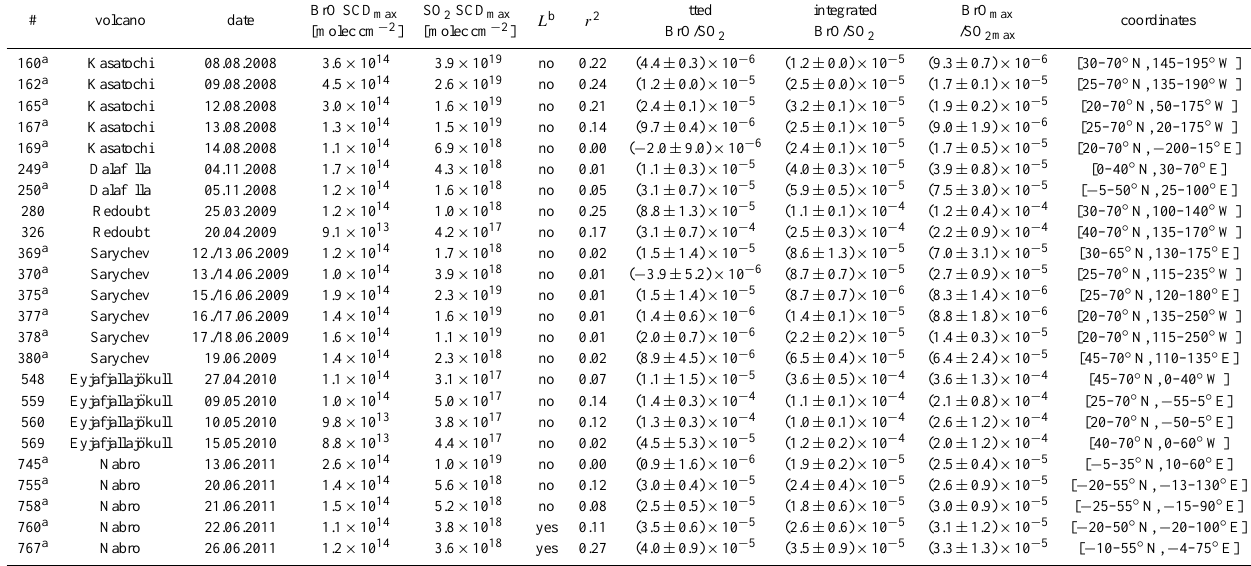
Table 6. Category III ( eruptions with enhanced BrO cluster, but no linear correlation ) BrO/SO 2 -analysis of all detected volcanic plumes of Category III. Columns contain: event number, volcano, measurement date, max. BrO SCD, max. SO 2 SCD, coincidence of max. SO 2 and BrO SCD, r 2 , BrO/SO 2 slope, ratio of integrated BrO and SO 2 molecules, ratio of max. SO 2 and coordinates of regarded